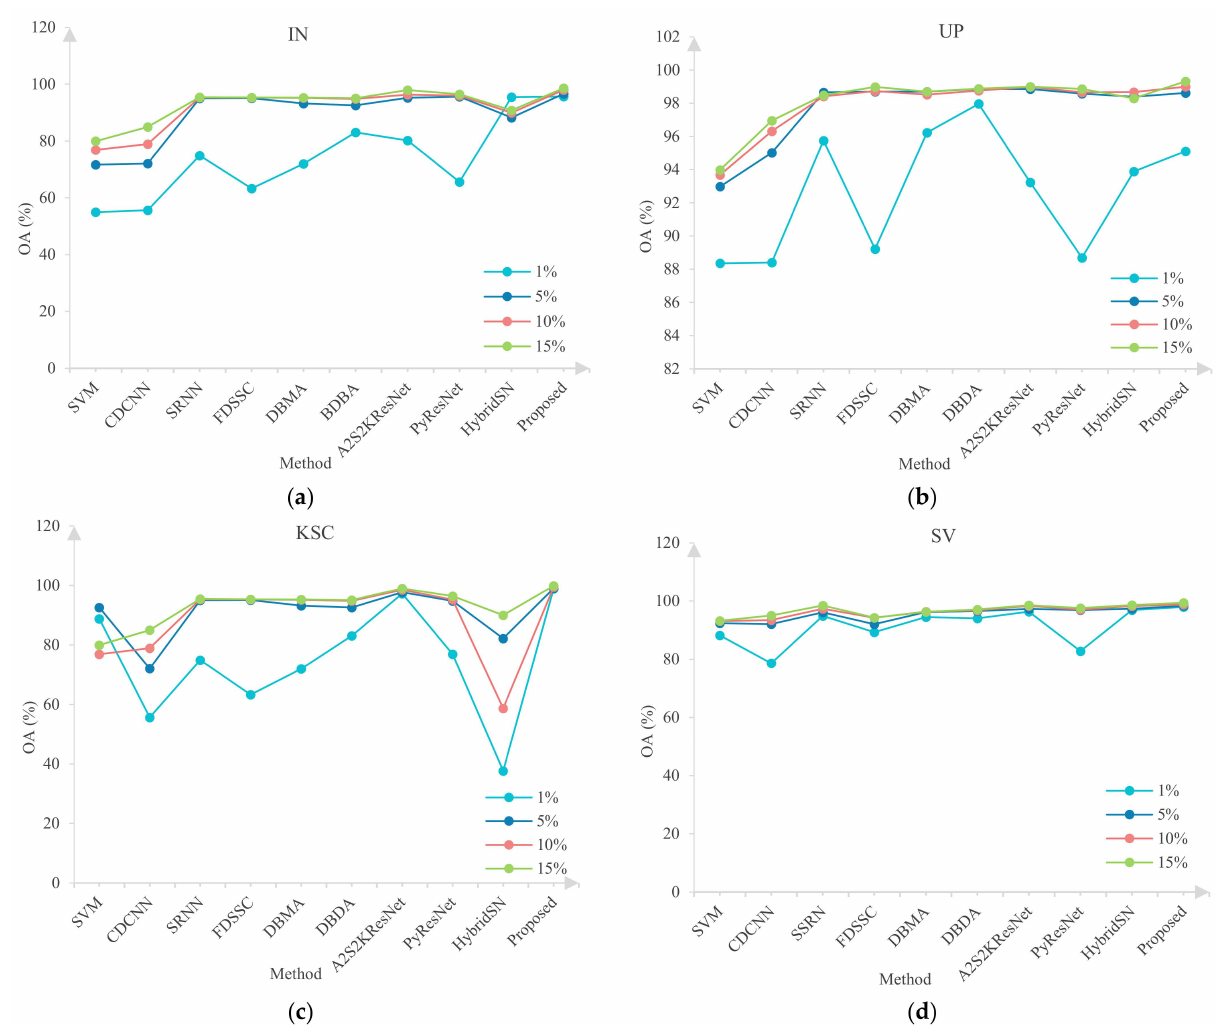
Figure 15. Classification performance of different methods under different training sample ratios on IN, UP, SV, and KSC datasets: ( a ) classification results on IN dataset; ( b ) classification results on the UP dataset; ( c ) classification results on the SV dataset; ( d ) classification results on the KSC